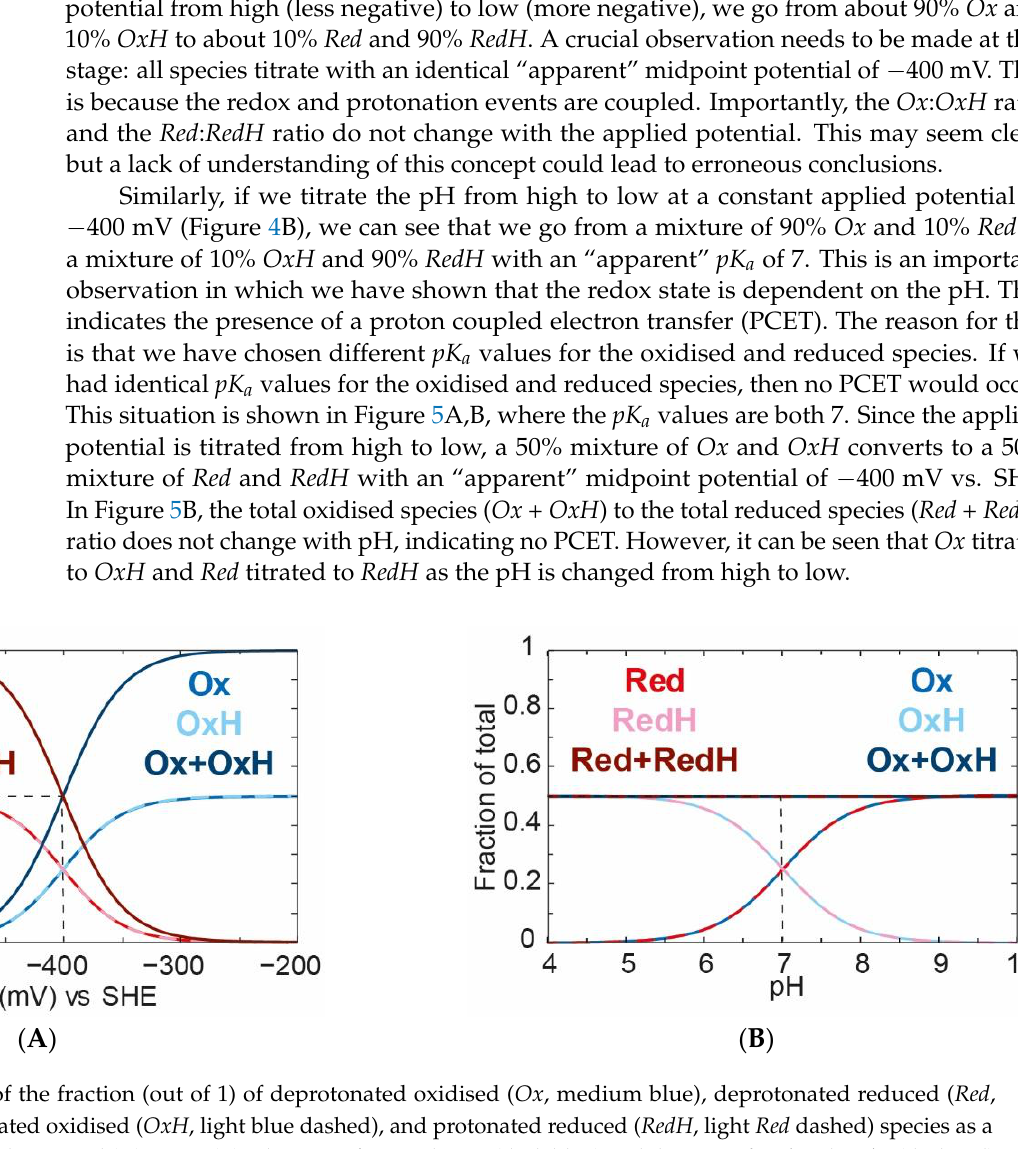
Figure 6. Variation of the fraction (out of 1) of deprotonated oxidised ( Ox ) species as a function of the applied potential at pH 6 (light blue), pH 7 (medium blue), and pH 8 (dark blue). The curves were obtained using Equations (7), (11), (12), and (15), with 𝐸 1 𝑂 = −459 mV, K a, 1 = 10 −6 ( pK a, 1 = 6), K a, 2 = 10 −8 ( pK a, 2 = 8). 𝐸 2𝑂 was calculated using Equation (21) to be −341 mV, giving an average E O of −400 mV, for a comparison with Figure 2. As can be seen from Figure 6, the “apparent” midpoint potential for the titration of Ox shifts with pH, even if the change of Ox to Red itself does not directly involve a proton. However, the fundamental point is that the ratio between the Ox and OxH species will be the same at every value of the applied potential (as long as the pH is fixed). This is because the ratio between Ox and OxH is determined only by the acid dissociation constant K a, 1 . Thus, if the process of proton-coupled reduction of Ox to RedH can occur, then the titration of the total amount of the oxidised species ( Ox + OxH ) and the titration of the total amount of the reduced species ( Red + RedH ), will change with pH. It must, therefore, be the case that the titration of the component states changes with pH. To illustrate this, Figure 7 shows the titration of Ox, OxH , and Ox + OxH at pH 6 and pH 8. It is clear that, at pH 6, the Ox state titrates with a more positive “apparent” redox potential than at pH 8. The